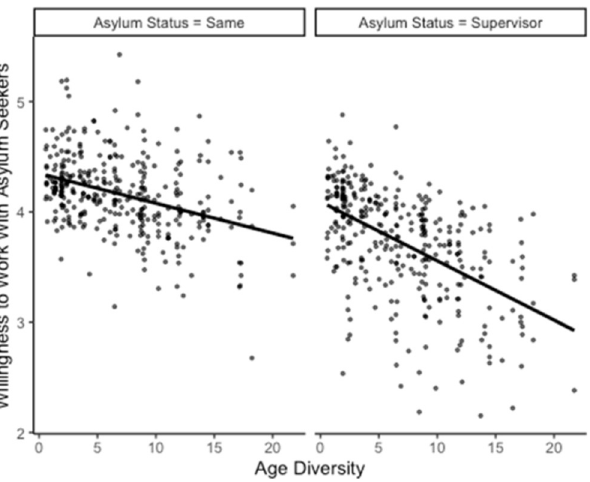
Fig 1. Significant interaction effect of status of the asylum seeker in one’s work team (same status vs. supervisor role) and age diversity on willingness to collaborate with asylum seekers, controlled for control variables.